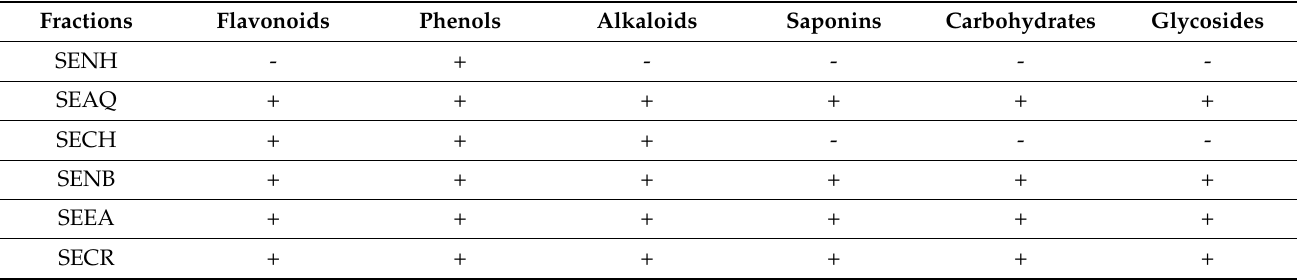
Table 1. Phytochemical composition of S. edelbergii